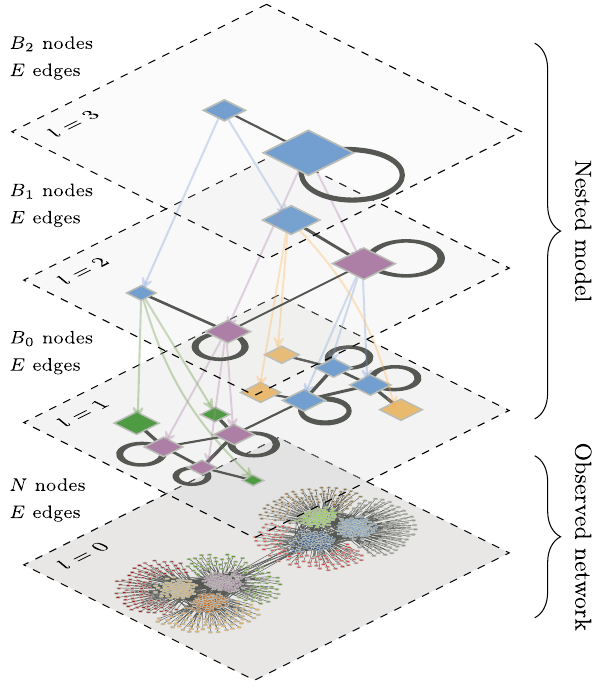
FIG. 1. Example of a nested stochastic block model with three levels, and a generated network at the bottom. The top-level structure describes a core-periphery network, which is further subdivided in the lower